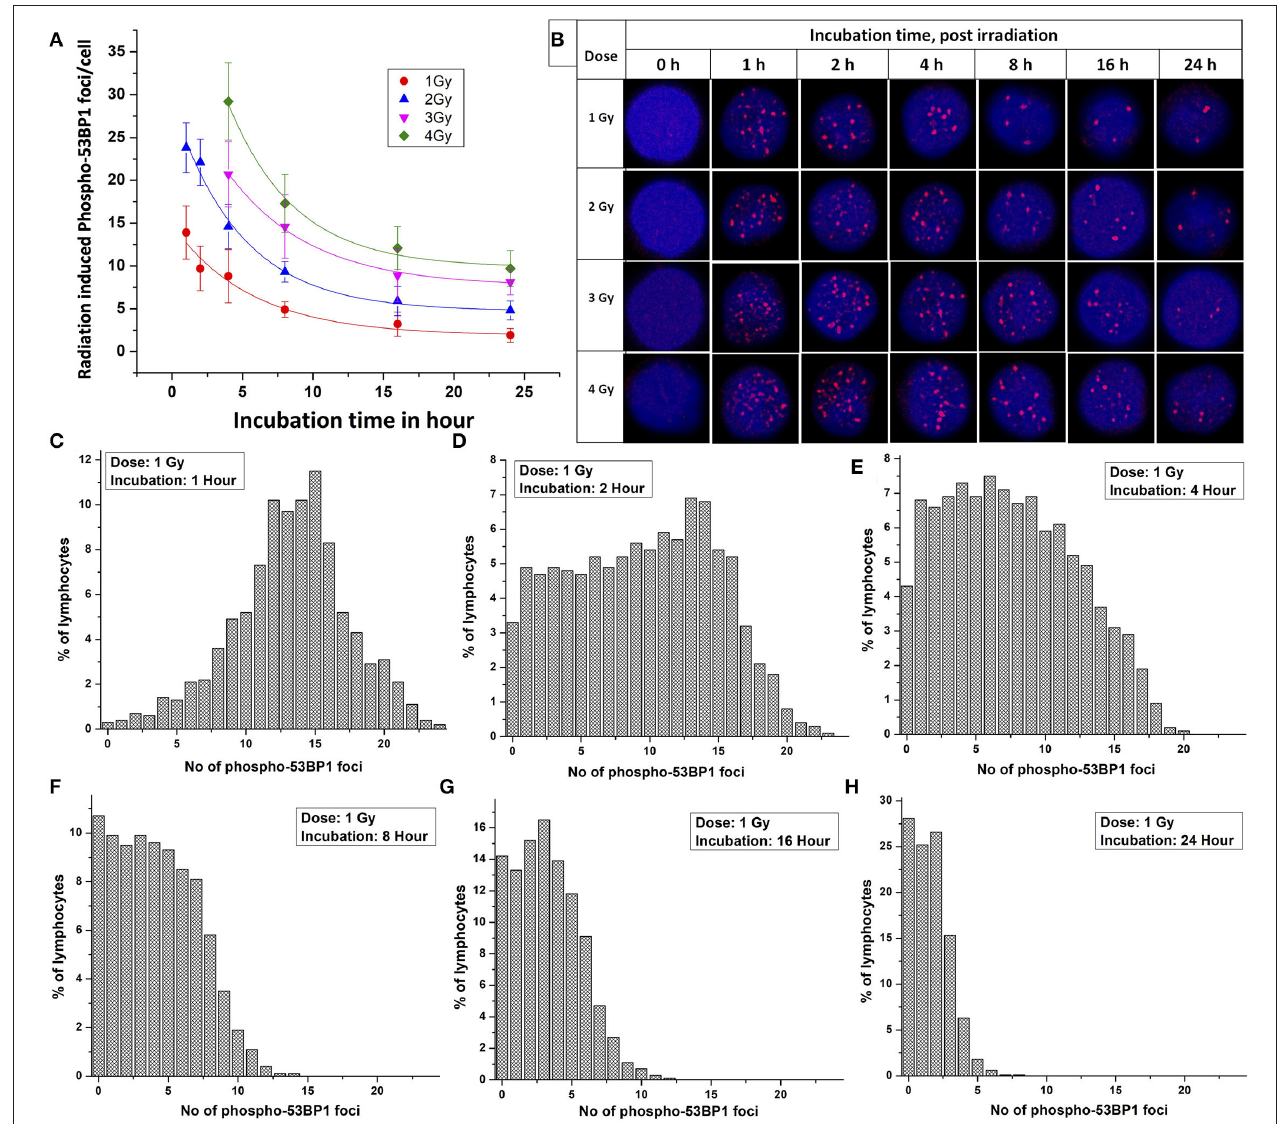
FIGURE 2 | (A) Phospho-53BP1 foci, decay kinetics, in the blood sample of five volunteers [two females (with age 22 and 24 y) and three males (with age 25 y, 31 y and 35 y)] after irradiation with 1, 2, 3, and 4Gy. Error bars represents SEM ( n = 5 × 3, i.e., five volunteers with triplicate sampling). Number of cells analyzed/scored > 300/dose/time point/volunteer. (B) Illustration of the disappearance of phospho-53BP1 foci at 1, 2, 4, 8, 16, and 24h of incubation after irradiation with 1, 2, 3, and 4Gy. Dispersion of the number of phospho-53BP1 foci in PBLs irradiated with 1Gy (cumulative data of all five volunteers) after incubation of (C) 1h (D) 2h (E) 4h (F) 8h (G) 16h, and (H) 24h.